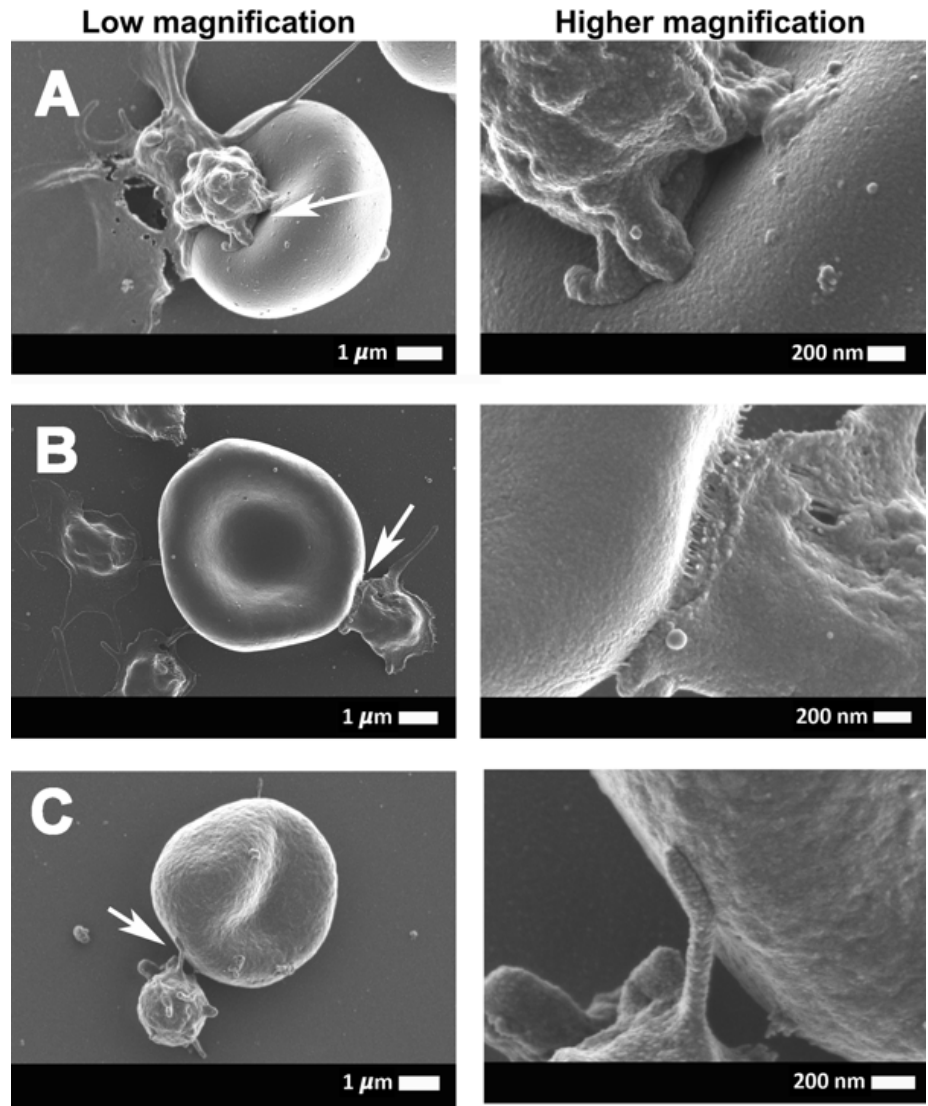
Figure 5. ( A – C ) A continuation of the representative scanning electron micrographs of the interaction between the erythrocytes and platelets of COVID-19-positive patients. ( A – C ) (column on the left) shows the low magnification micrographs of the platelet-erythrocyte interactions, with the corresponding high magnification micrographs (column on the right) to show the ultra-structures of the interactions. Arrows point to the area that was focused on.